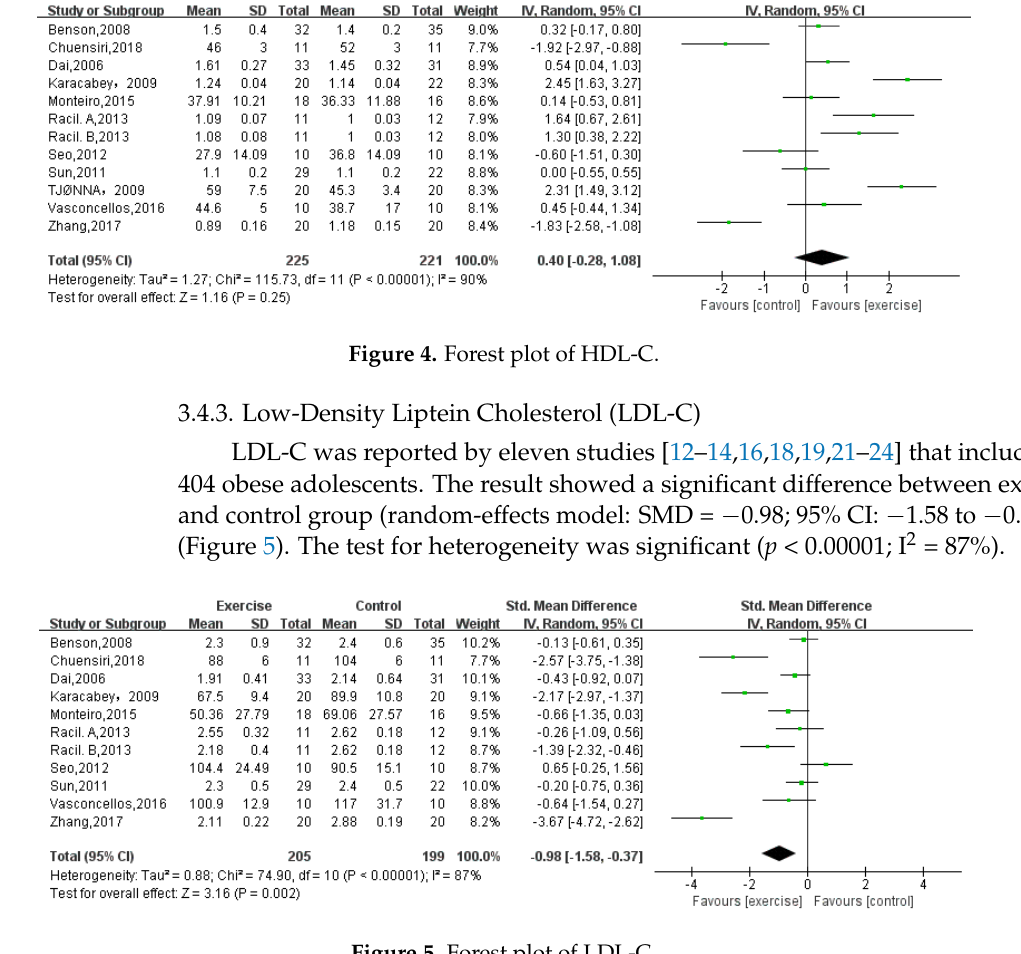
Figure 6. Forest plot of TG. 3.4.5. Total Cholesterol (TC) Ten [12,13,16,18,19,21 – 24] studies with a total of 364 obese adolescents reported a significant difference in TC (random-effects model: SMD = − 1.00 ; 95%CI: − 1.73 to −0. 26; p = 0.008) (Figure 7). The test for heterogeneity was significant ( p < 0.00001; I 2 = 90%). Figure 7. Forest plot of TC. 3.4.6. Peak Oxygen Uptake (VO 2 peak) VO 2 peak was reported by twelve studies [6,13,15 – 17,19,20,22,24] that included a total of 414 obese adolescents. The meta-analysis showed a significant difference between the